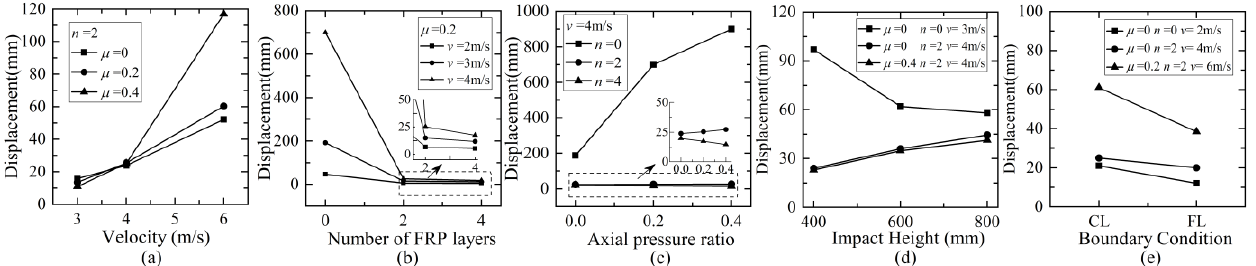
Figure 12. Maximum lateral displacement at the impact height versus: ( a ) impact velocity; ( b ) number of CFRP layers; ( c ) axial compression ratio; ( d ) impact height; ( e ) boundary condition.